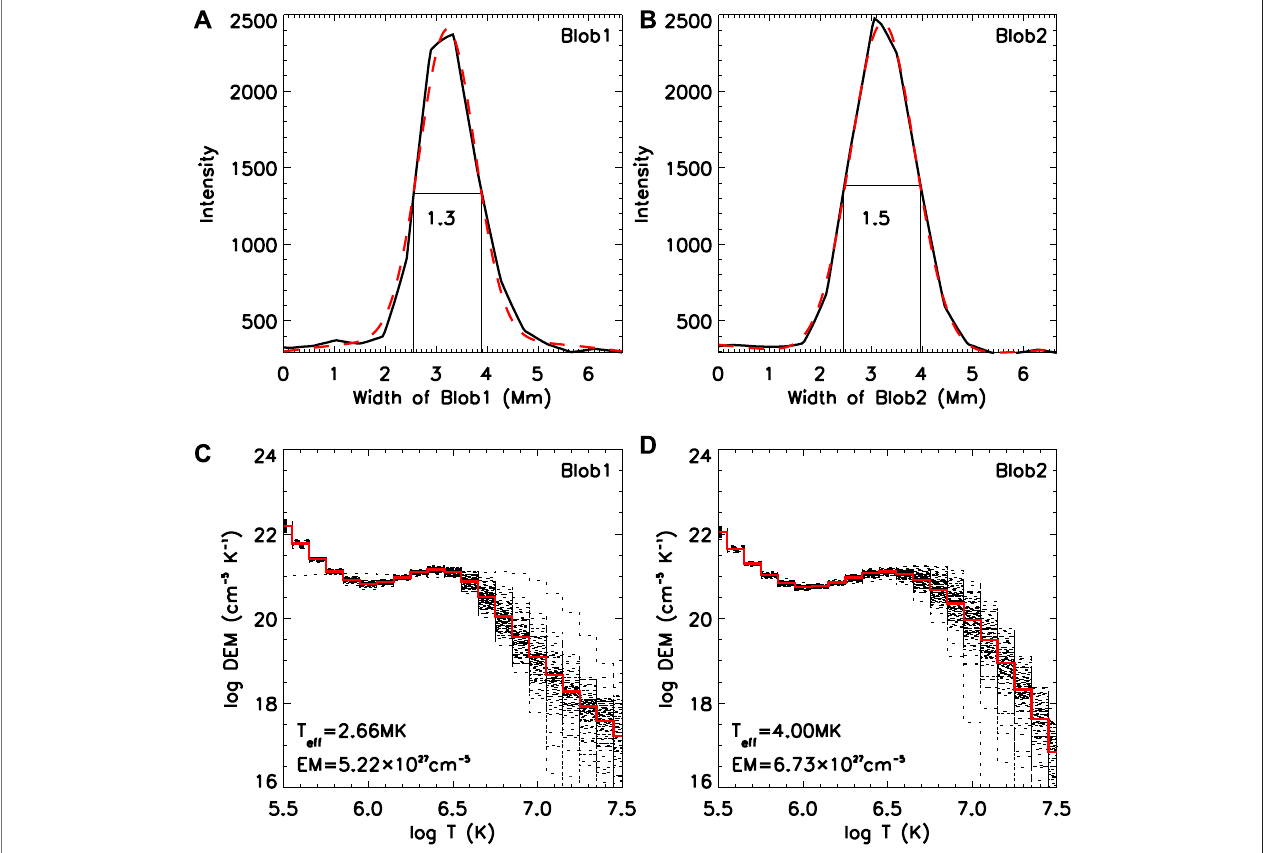
FIGURE5| Thewidth(upperpanels)andDEMdistribution(lowerpanels)ofBlobs1and2inPhase1.In (A) and (B) :theblacksolidcurvesaretheintensityvariation of the Blobs 1 and 2 perpendicular to the jet; the red dashed lines are Gaussian fi tting with the width values taken at the full width of half maximum (FWHM) after subtracting the background intensity values. (C) and (D) show the DEM pro fi les of the core regions in Blobs 1 and 2; the red solid lines stand for the best- fi tted DEM curves from the observed values; the black lines represent the reconstructed curves from the 100 MC simulations.